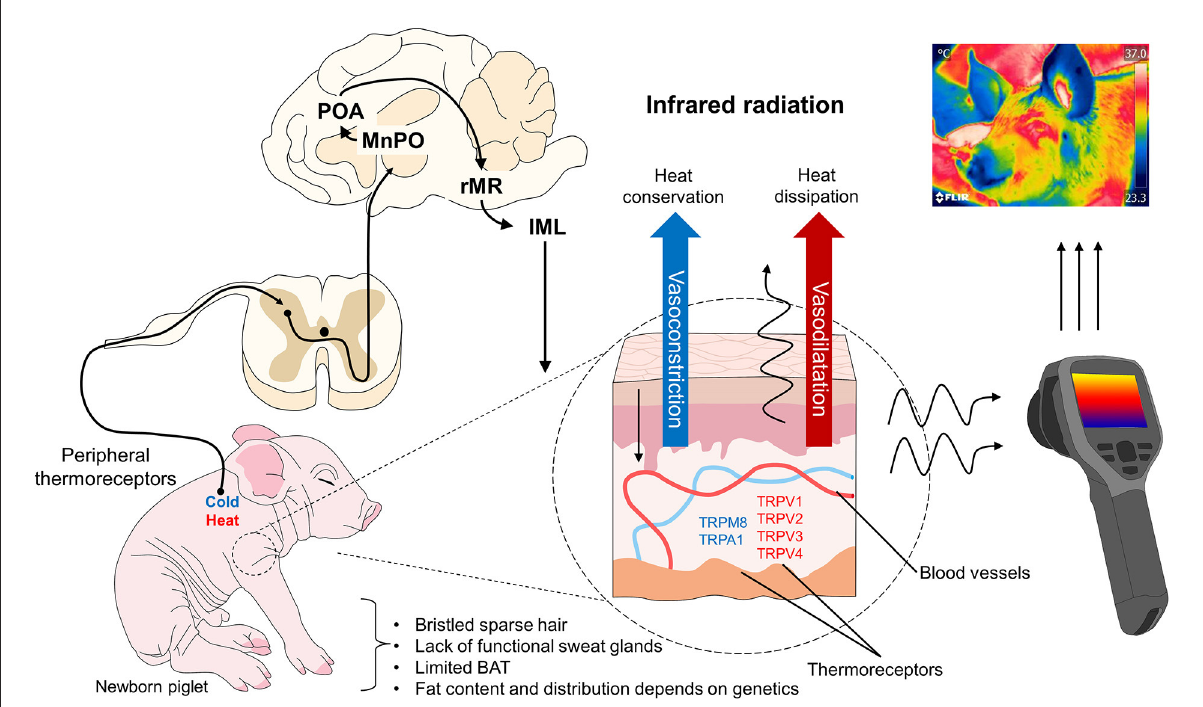
FIGURE3 Thermoregulatory mechanism in domesticated swine. When peripheral thermoreceptors are activated to recognize cold or hot stimuli, the information is transmitted to the hypothalamus (MnPO) and other brain structures involved in the sympathetic control of peripheral blood vessels. When exposed to cold environments, these vessels vasoconstrict to conserve heat, but under exposure to hot temperatures, they vasodilate to dissipate heat. Both responses influence the amount of infrared radiation observable using techniques like IRT, though this also depends on the thermal window evaluated. IML, intermediolateral column; MnPO, median preoptic nucleus; POA, preoptic area; rMR, rostral medullary raphe; TRP, transient receptor potential vanilloid (V), melastatin (M), ankyrin